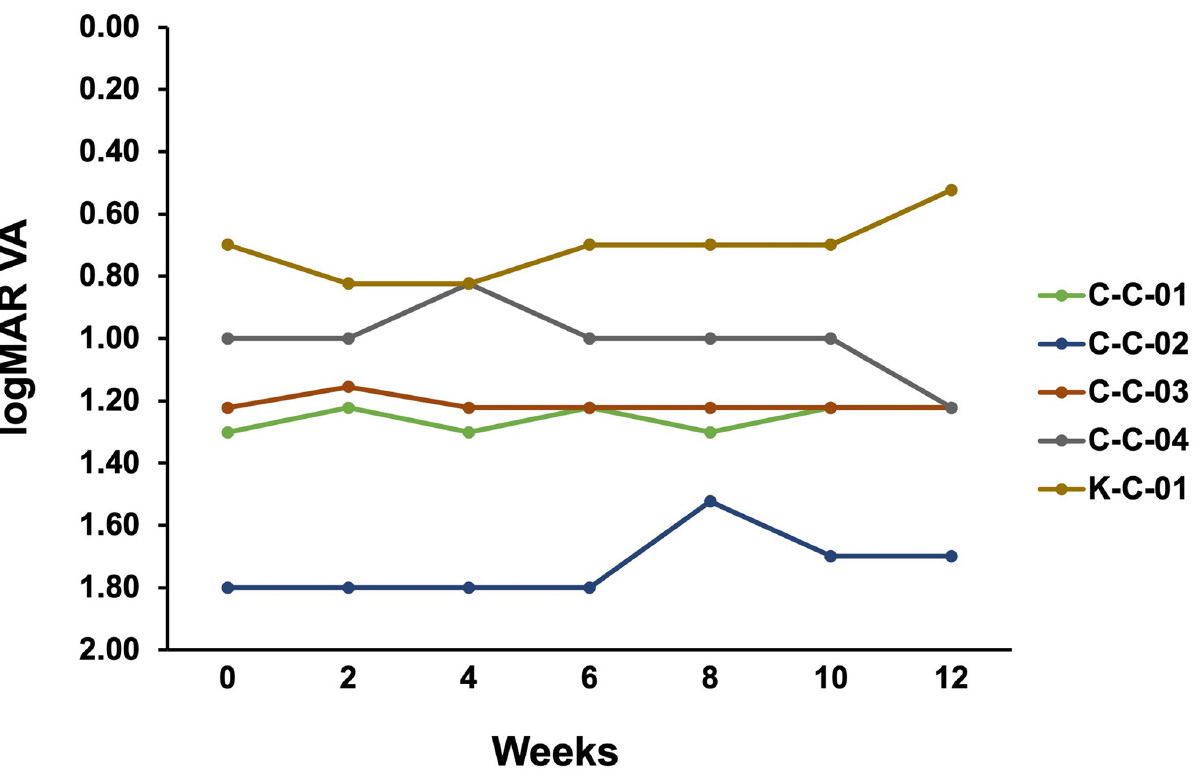
Fig 2. logMAR visual acuity for each case during the study period.